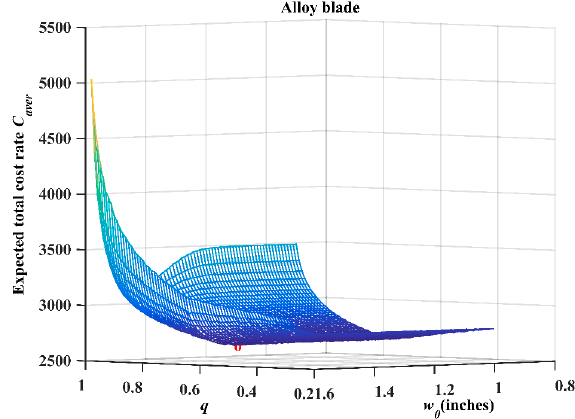
Figure 11. The relationship between the expected total cost rate 𝐶 (cid:3028)(cid:3049)(cid:3032)(cid:3045) , the PM threshold 𝑤 (cid:2868) and the real-time reliability threshold 𝑞